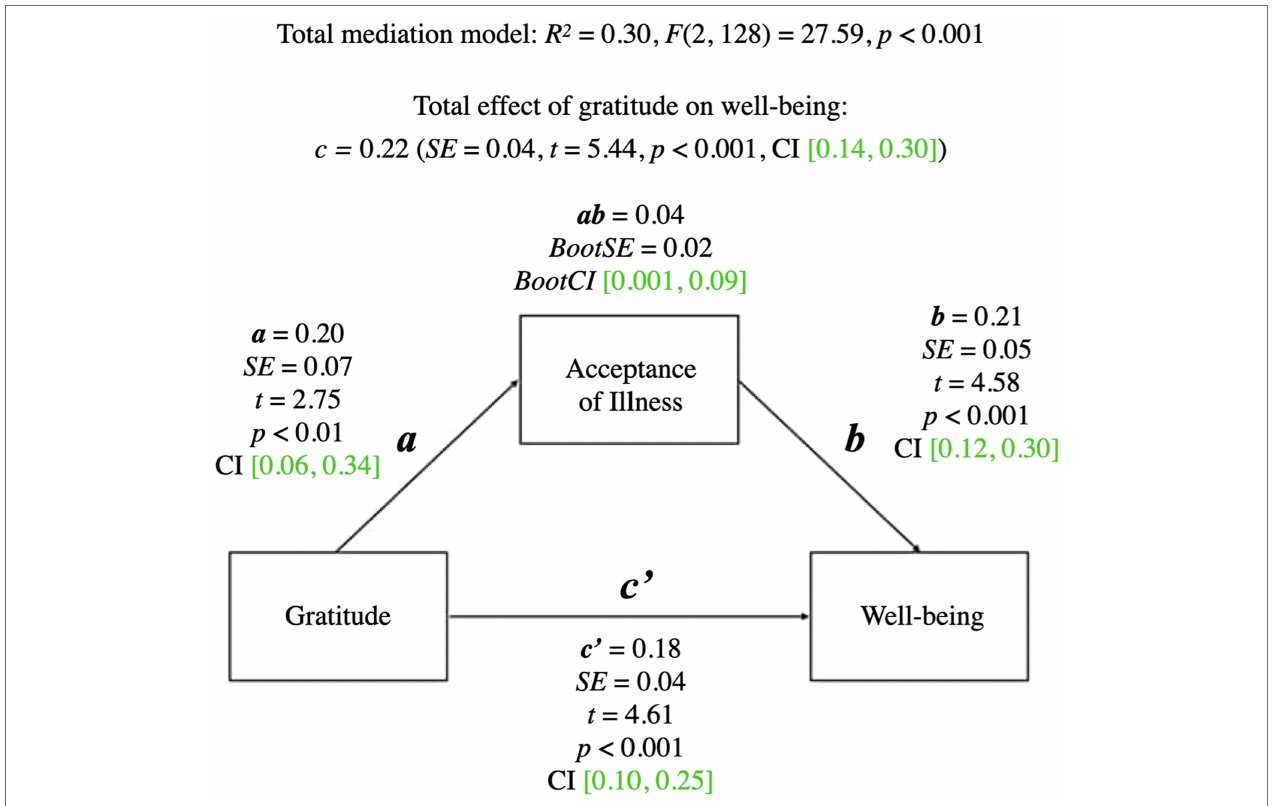
FIGURE 1 | Mediation model for gratitude and wellbeing. a, effect of Gratitude on Acceptance of Illness; b, effect of Acceptance of Illness on wellbeing; ab, indirect effect of Gratitude on wellbeing; c', direct effect of Gratitude on wellbeing; c, total effect of Gratitude on wellbeing (ab + c'); CI, confidence intervals; CI, marked green indicate